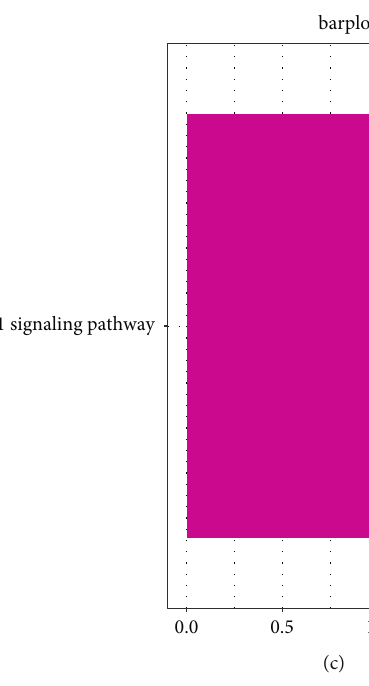
Figure 2: (a) DO, (b) GO, and (c) KEGG pathway analyses of 20 DEG in